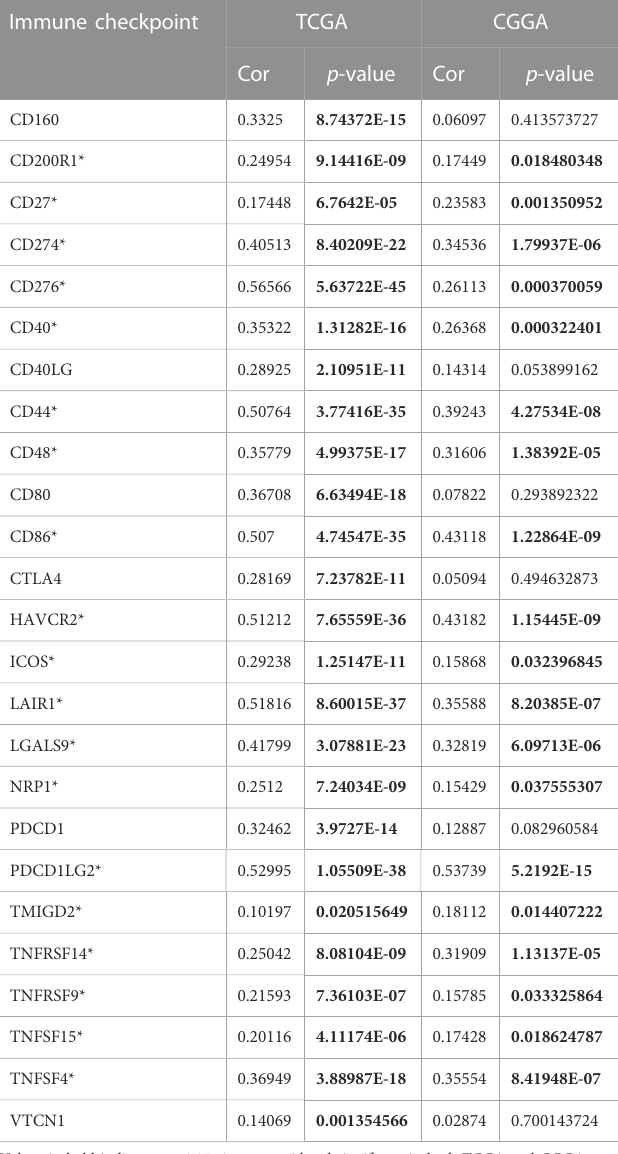
TABLE 1 Correlations between the FDX1 expression and immune checkpoints in TCGA-LGG and CGGA-LGG datasets. Immune